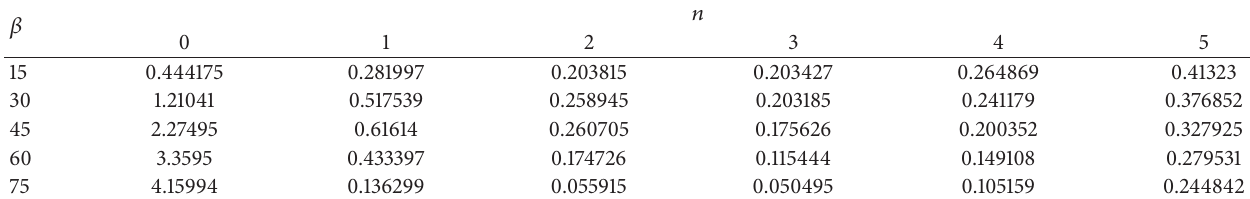
Table 5: Nondimensional frequency variation of fixed PMMA/CNT composite shell for 𝑉 ∗ CN = 0.12 .